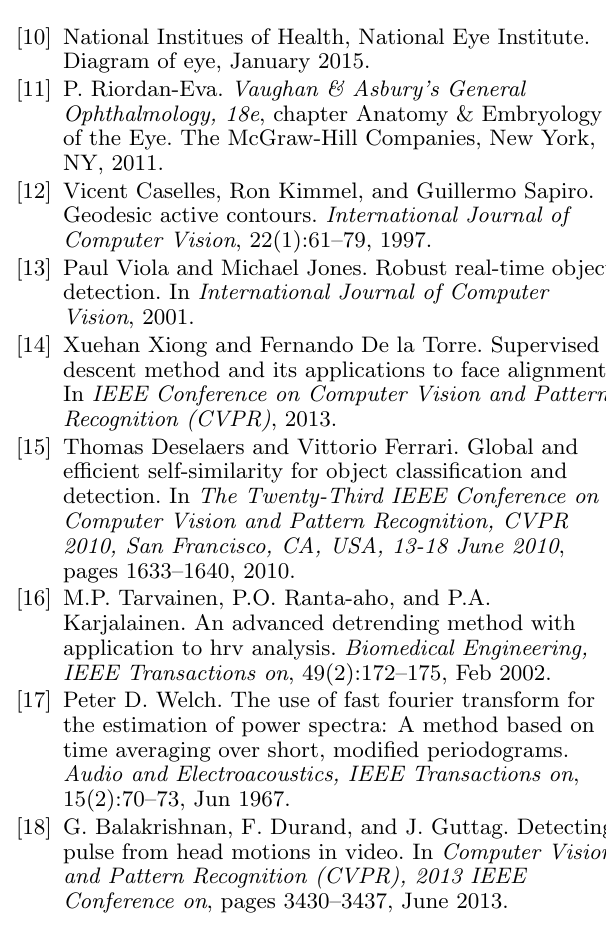
Figure 5: Pulse rate measurements for cheek region in infrared image. (a) Infrared intensity. (b) GSS filtering. (c) Detrending. (d) Normalization. (e) Moving average filtering. (f) Band pass filtering. (g)